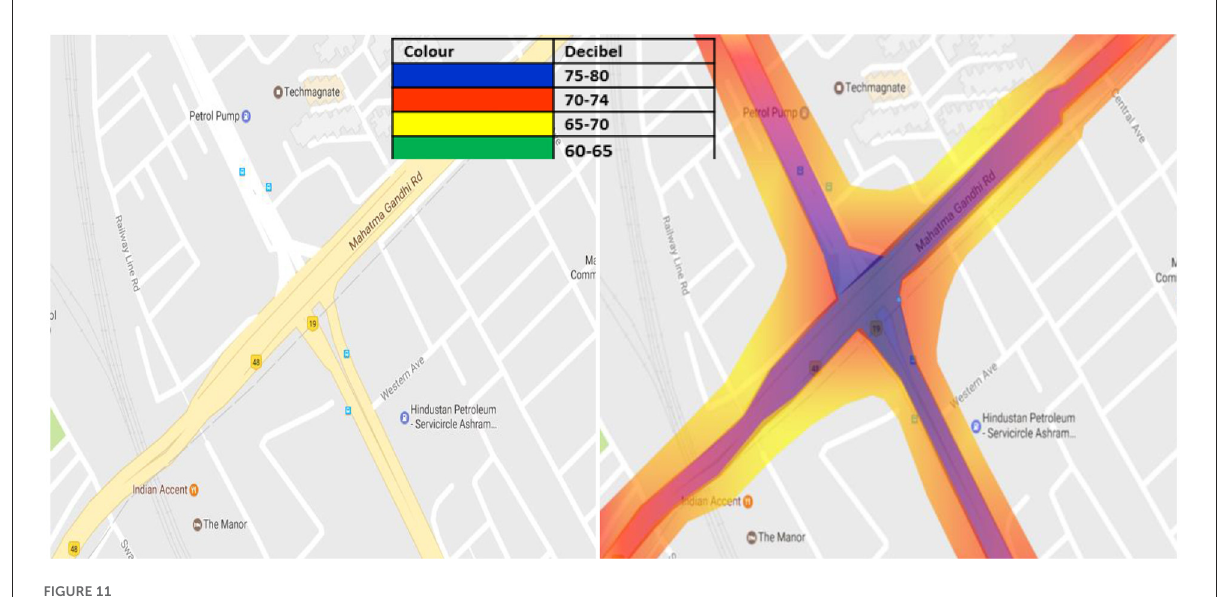
FIGURE11 2D noise mapping of residential area.